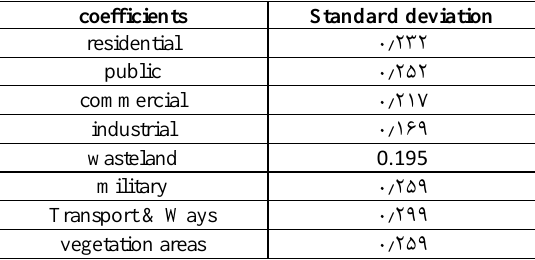
Table 3. Standard deviation of regression coefficients